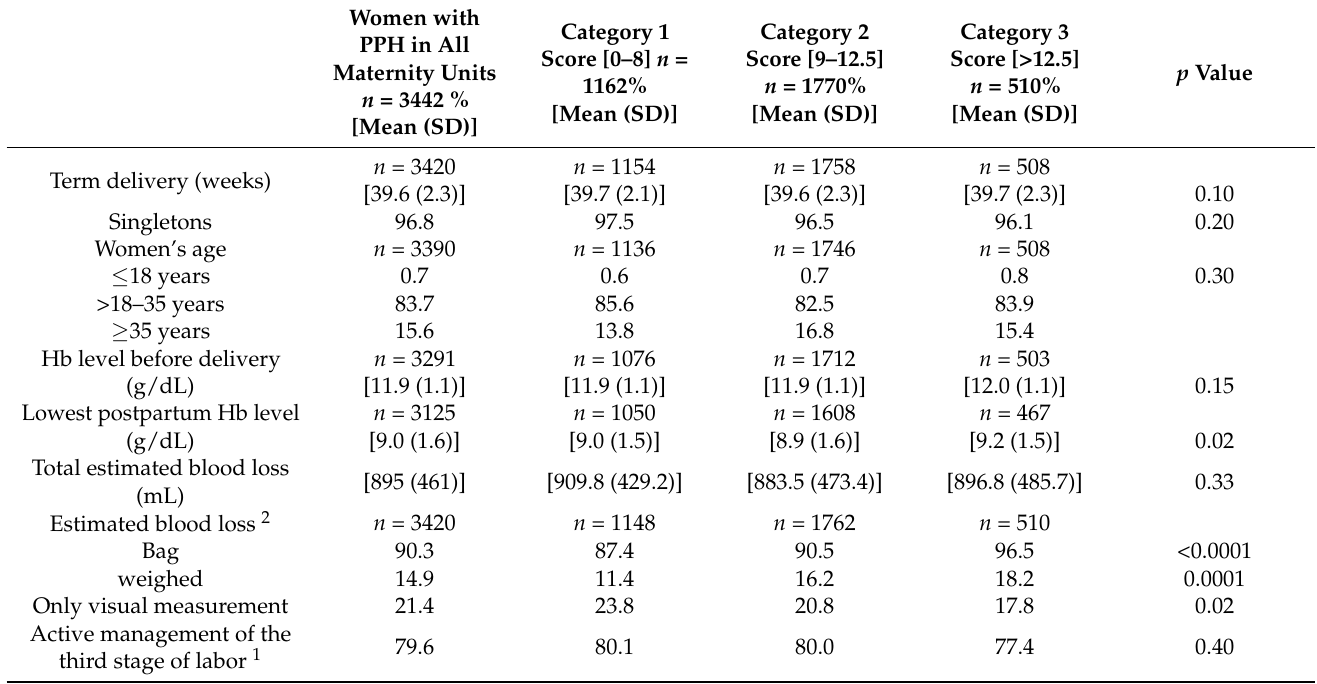
Table 2. Description of medical data of women who had a PPH after a vaginal birth, overall and according to the protocol-quality category.